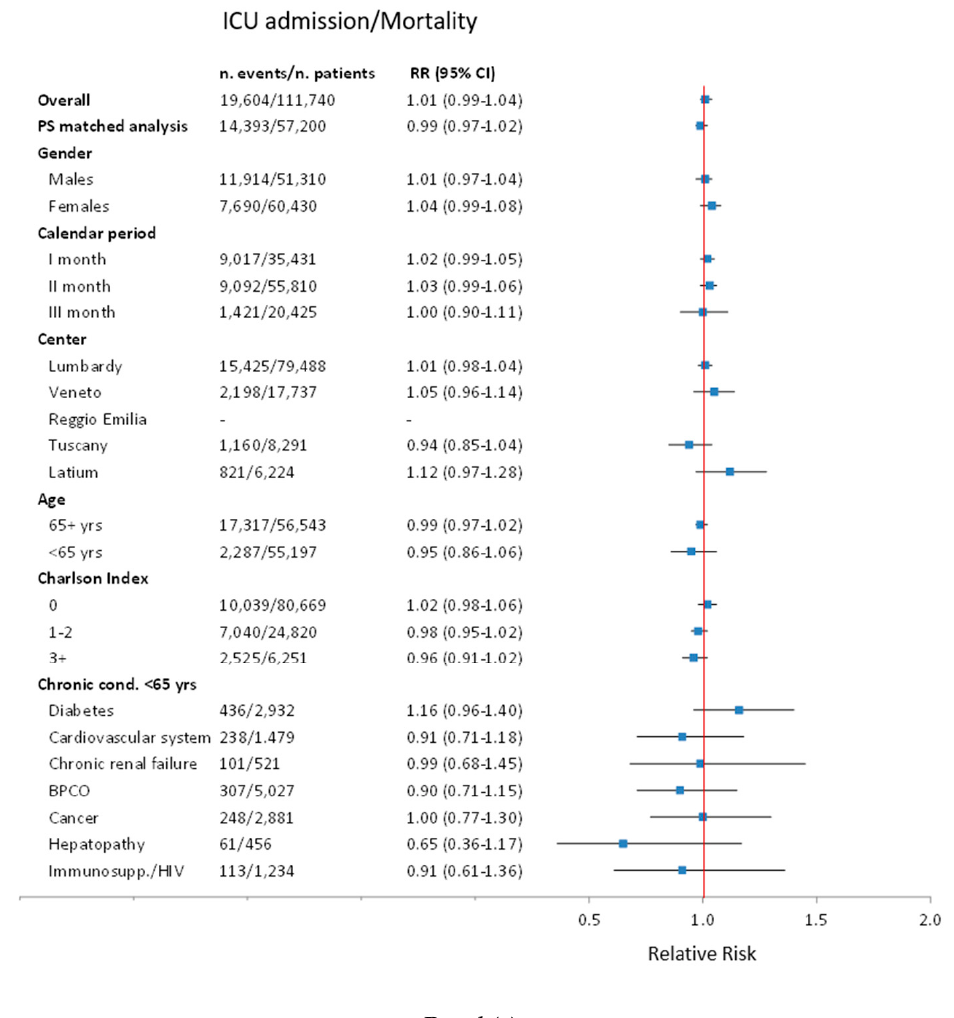
Figure 2. Sensitivity and subgroup analyses of association between flu vaccination and COVID-19 hospitalization panel ( a ), mortality panel ( b ), and admission to ICU or mortality panel ( c ). PS—Propensity Score; yrs—years; Cond.—Conditions; COPD—Chronic obstructive pulmonary disease; Immunos—Immunosuppression; HIV—Human Immunodeficiency Virus infection; ICU—Intensive Care Unit.